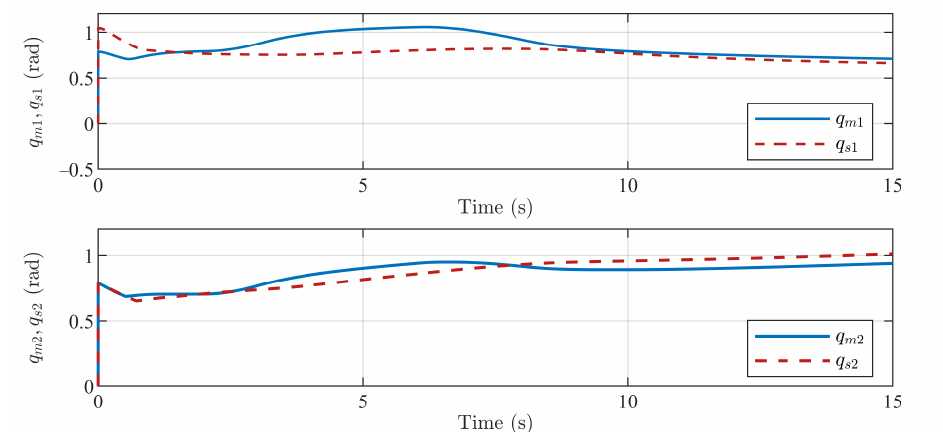
Figure 10. Joint positions of the master and slave end-effectors with the method in Case 1.